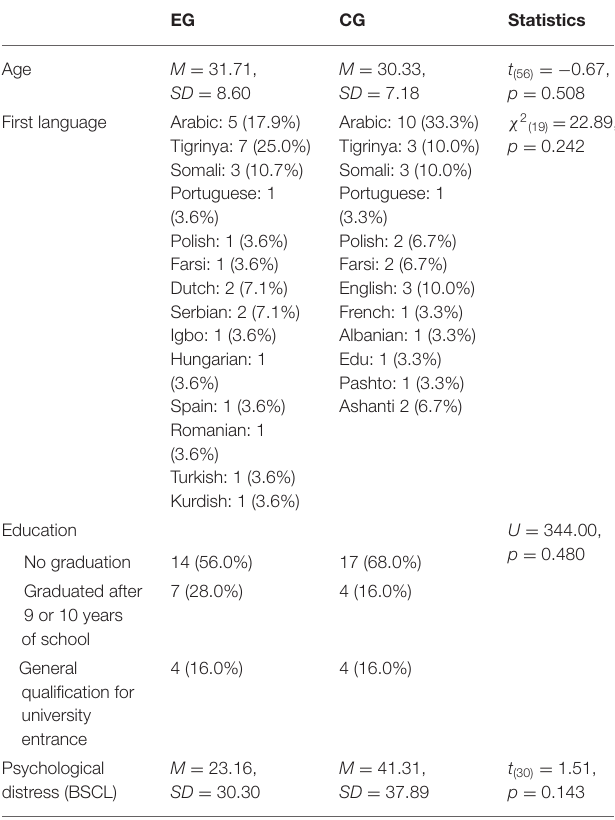
TABLE 2 | Descriptive statistics of the participants in the experimental (EG) and control group (CG). EG CG